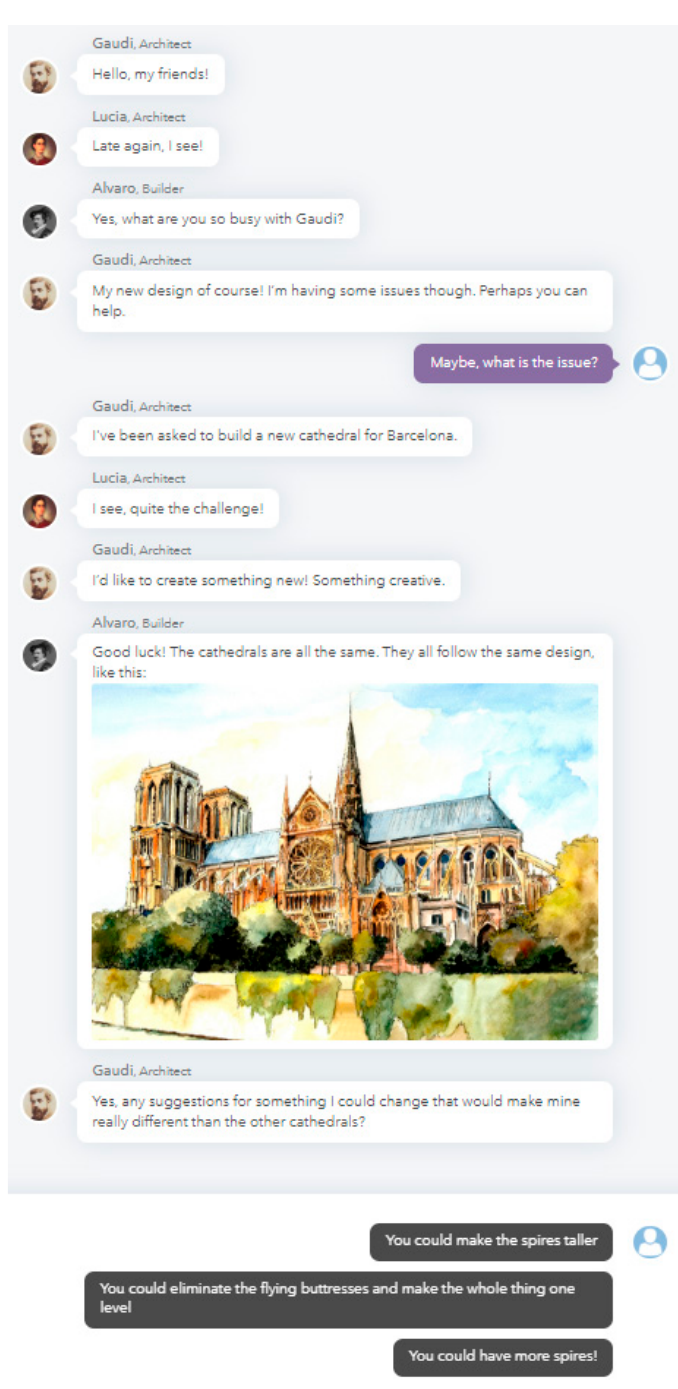
Figure 2. Illustration of the conversational task called Architecture Design Challenge.